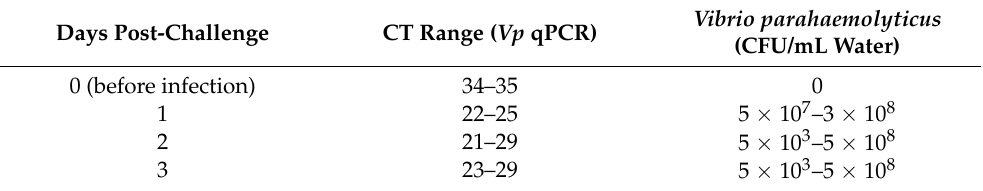
Table 7. Detection of Vibrio parahaemolyticus by Vp qPCR assay in water of tanks with challenged shrimps. CT range and equivalencies in CFU/mL in water samples collected from maintenance tanks at different post-challenge